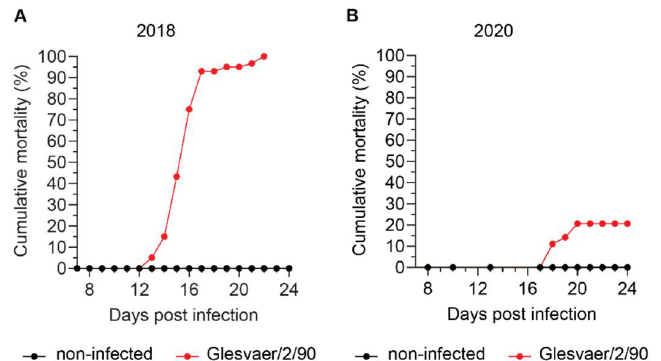
Figure 2. Cumulative mortality in the two ISAV infection trials used in this study. Materials analysed in this study were harvested from two independent ISAV infection trials conducted at different locations and in different years. ( A ) Cumulative mortality in the 2018 trial (results have been published previously [24], but are included for reference). ( B ) Cumulative mortality in the 2020 trial. range observed in non-infected individuals (Figure 3A,B). In the 2018 trial (Figure 3A), the